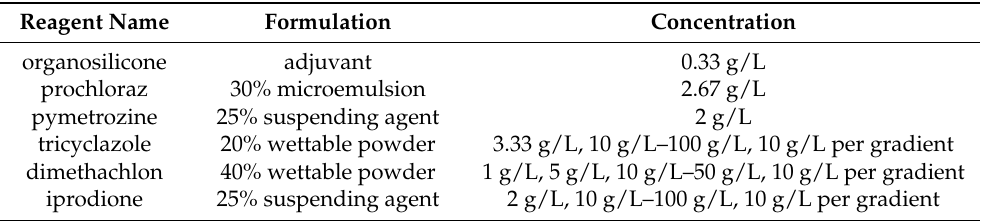
Table 2. Reagent name, formulations, and concentrations of plant protection products